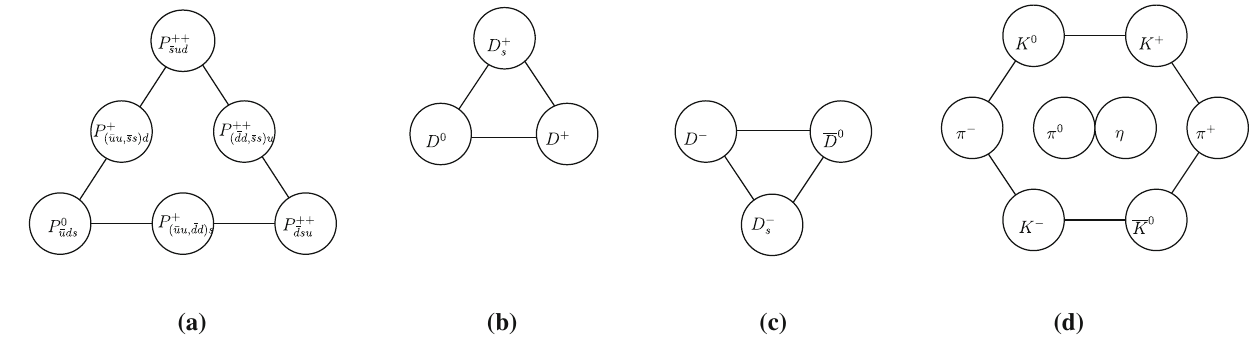
Fig. 1 The weight diagram for the pentaquark sextet P 6 is given in ( a ). Besides, The weight diagrams of mesons, provided in ( b – d ), charmed mesons anti-triplet and triplet to be ( b , c ), light meson octet to be ( d )